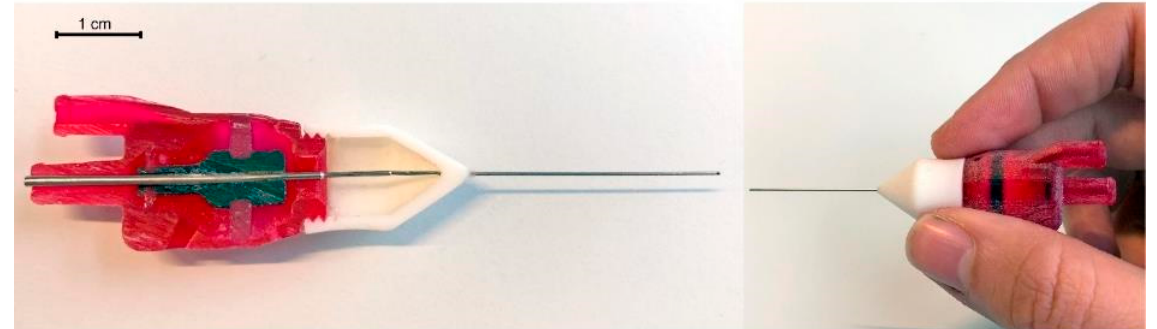
Figure 6. Initial prototype of the non-assembly vitrectome. Left : 3D printed model of the vitrectome cut in half, showing the two knives, the carrier in black and the diaphragms in light red. Right : 3D printed model of the vitrectome. The attachment of the outer diaphragm can be seen as a black line through the red housing. Diameter outer knife 0.4 mm, length outer knife 28 mm, length entire 3D printed vitrectome 80 mm.